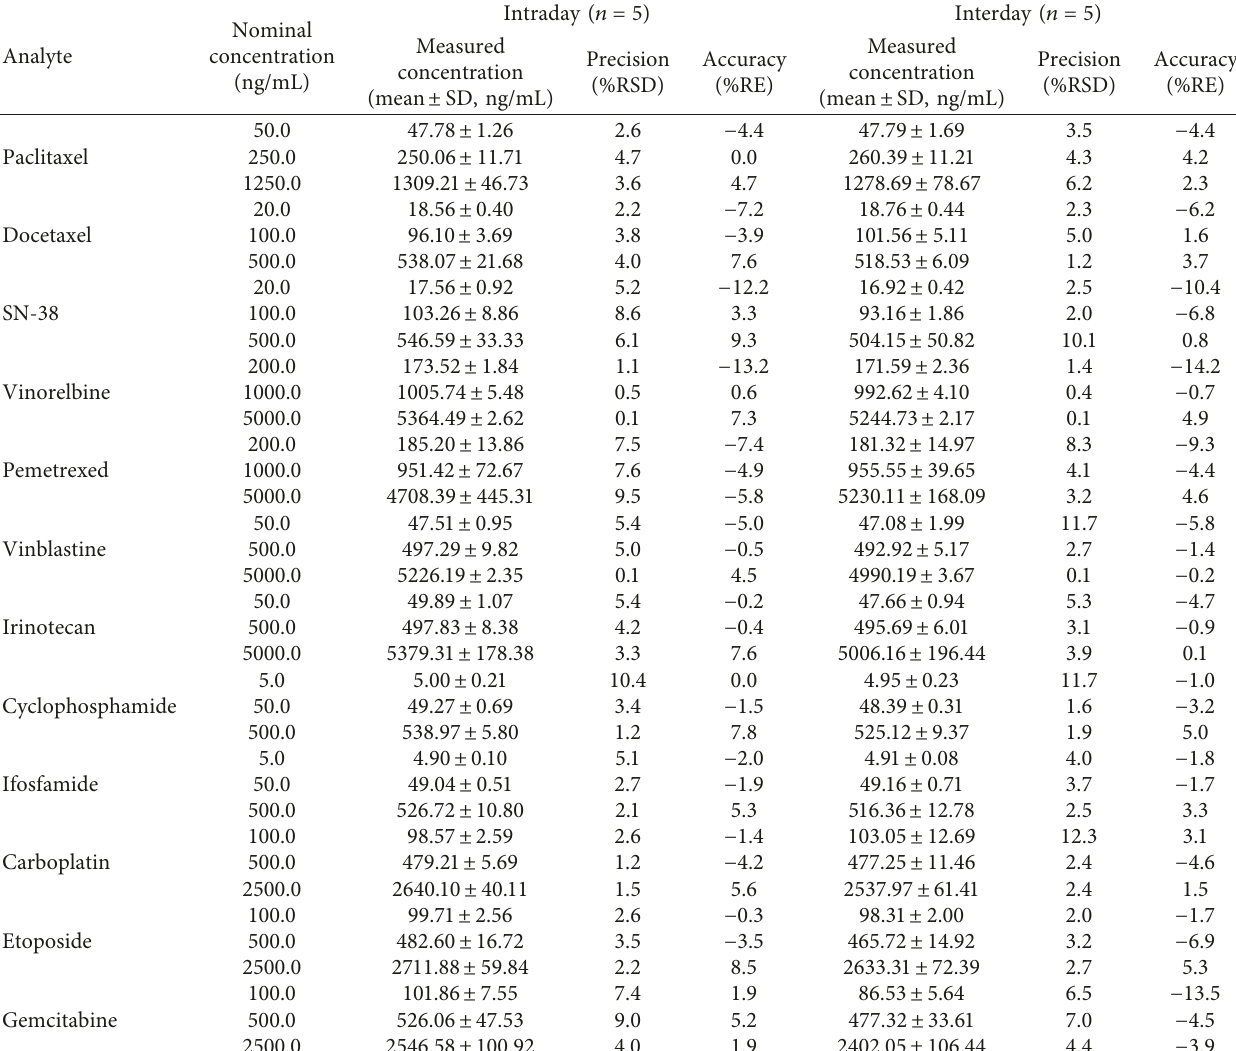
Table 5: Intraday and interday precision and accuracy of the analytes in human plasma ( n � 5).